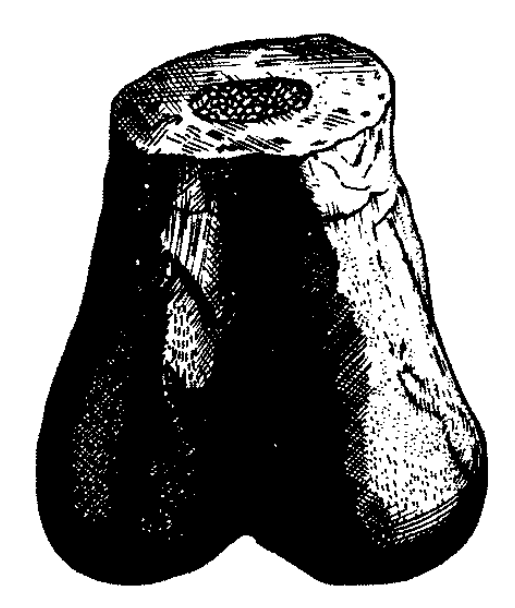
Fig. 1 – The earliest known illustration of a dinosaur bone first figured by Robert Plot in 1677 and later by Richard Brookes in 1763 (after Sarjeant